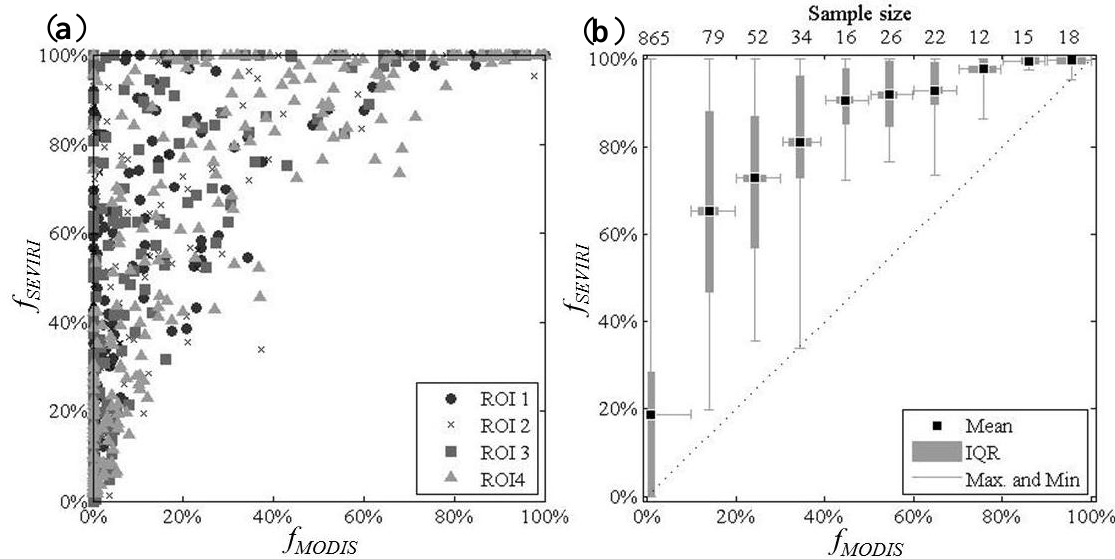
Figure 6. Comparisons between the internal cloud mask used during the processing of the MODIS active fire products and the SAFNWC cloud mask used during processing of the SEVIRI FRP-PIXEL product. In ( a ) are 1139 concurrent observations of the instantaneous cloud cover fraction in each ROI shown in Figure 1a, calculated for MODIS, f SEVIRI, f (see Equation (2)). Observations in (a) are aggregated over all ROIs and SEVIRI sorted into 10% bins of f , as shown in ( b MODIS